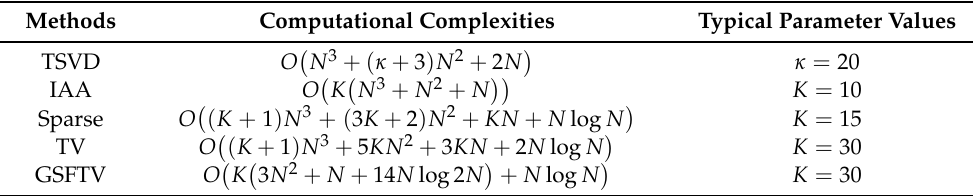
Table 1. Computational complexities of different methods.